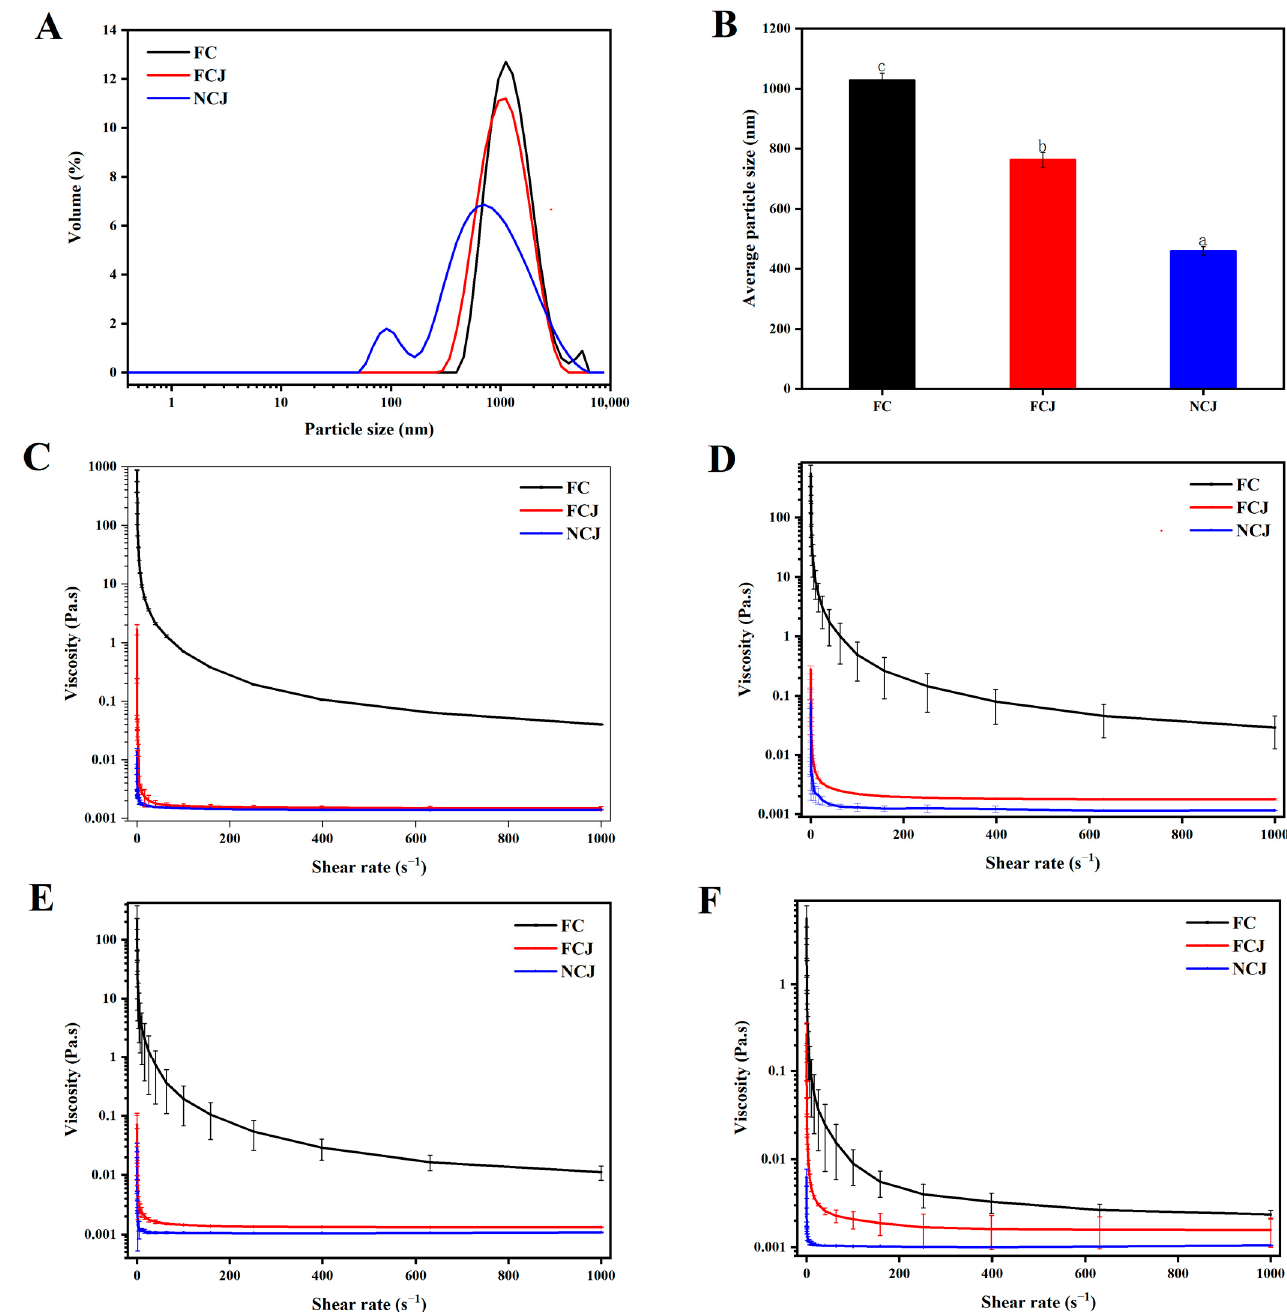
Figure 2. ( A , B ) Particle size distribution and average particle size in micellar media. ( C – F ) viscosity curves (apparent viscosity relative to the shear rate) of digestive fluids during digestion. ( C ) Initial phase; ( D ) Mouth phase; ( E ) Stomach phase; ( F ) Small intestine phase. Fresh citrus, fresh citrus juice, and not-from-concentrate citrus juice presented as FC, FCJ, and NCJ, respectively. Different lowercase letters represent significant differences, p < 0.05.